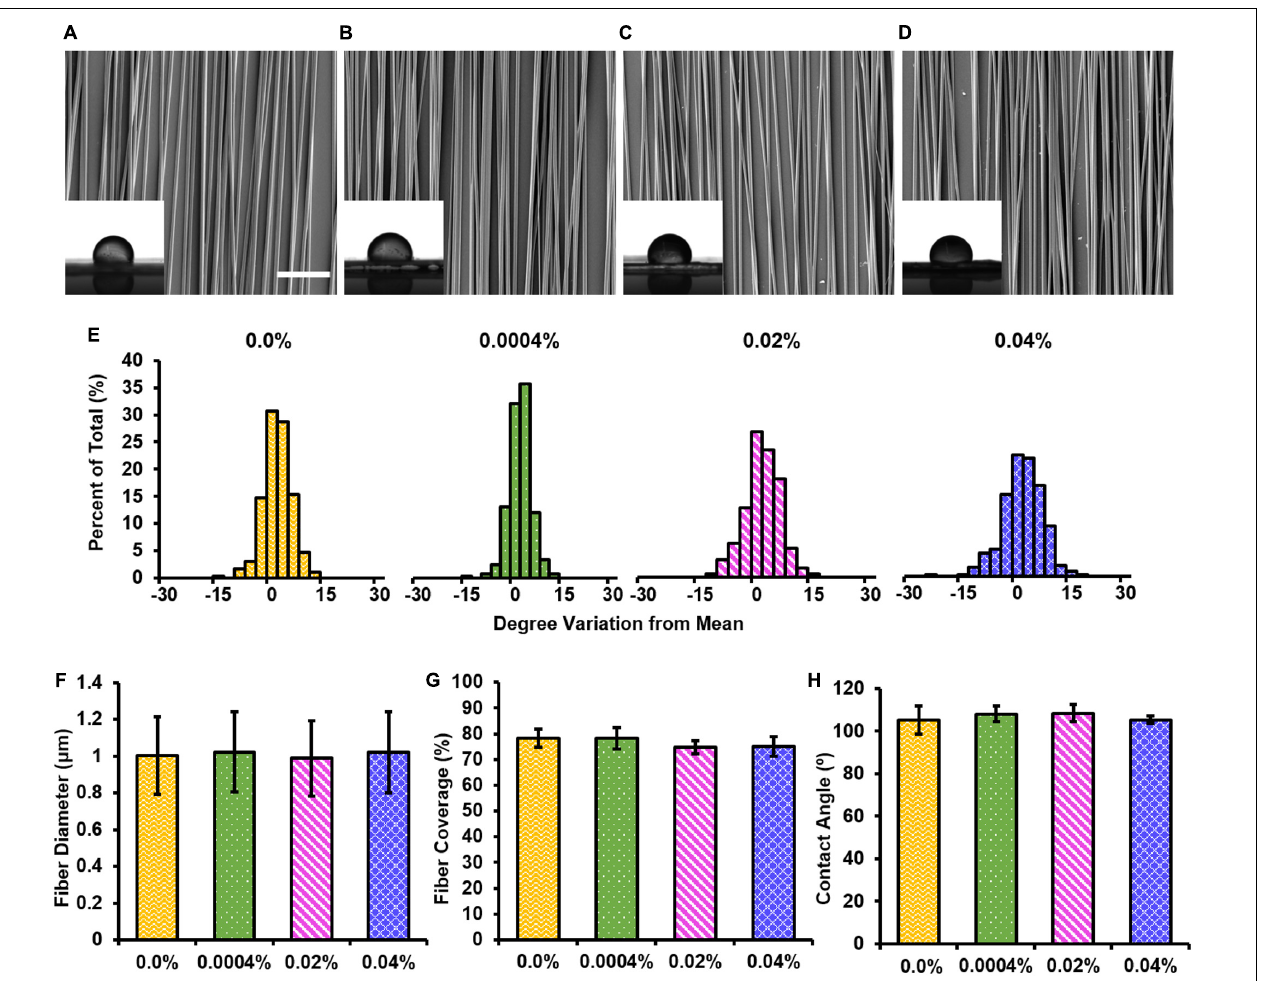
FIGURE 2 | Electrospun fibers containing various loading concentrations of fingolimod share similar morphological features. SEM images of (A) 0.0%, (B) 0.0004%, (C) 0.02%, or (D) 0.04% w/w fingolimod/poly(lactic-co-glycolic acid) electrospun fibers with inlaid images of water droplets used to measure static water contact angle for each (scale bar = 20 µ m). (E) Fiber alignment data for each loading concentration are represented by histograms displaying the percentage of fibers with a deviation from the mean fiber angle in degrees. (F) Fiber diameter data are represented as mean diameter (in µ m) ± standard deviation. (G) Fiber surface coverage data are represented by the mean percentage of the coverslip covered by fibers ± standard deviation. (H) Static water contact angle data (in degrees) are represented by the mean contact angle ± standard